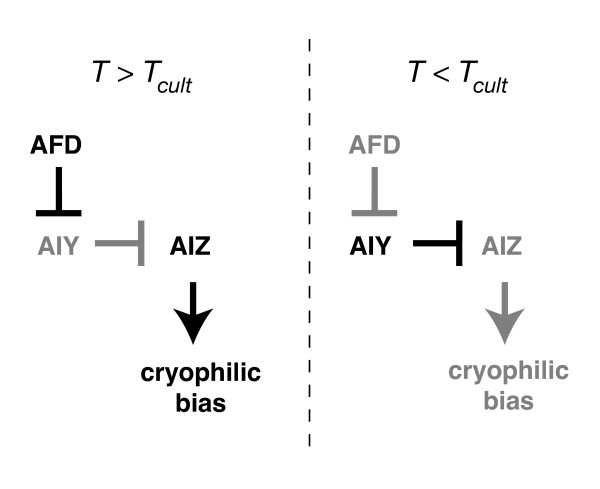
A gating model for AFD and AIY in generating cryophilic bias. In this schematic, the synaptic connections between AFD and AIY and between AIY and AIZ are inhibitory, and AIZ contributes directly to generating cryophilic bias. We suggest that patterns in the activity of the neural circuit differ when T > Tcult and when T <Tcult. High and low levels of activity are differentiated by black and gray, respectively.